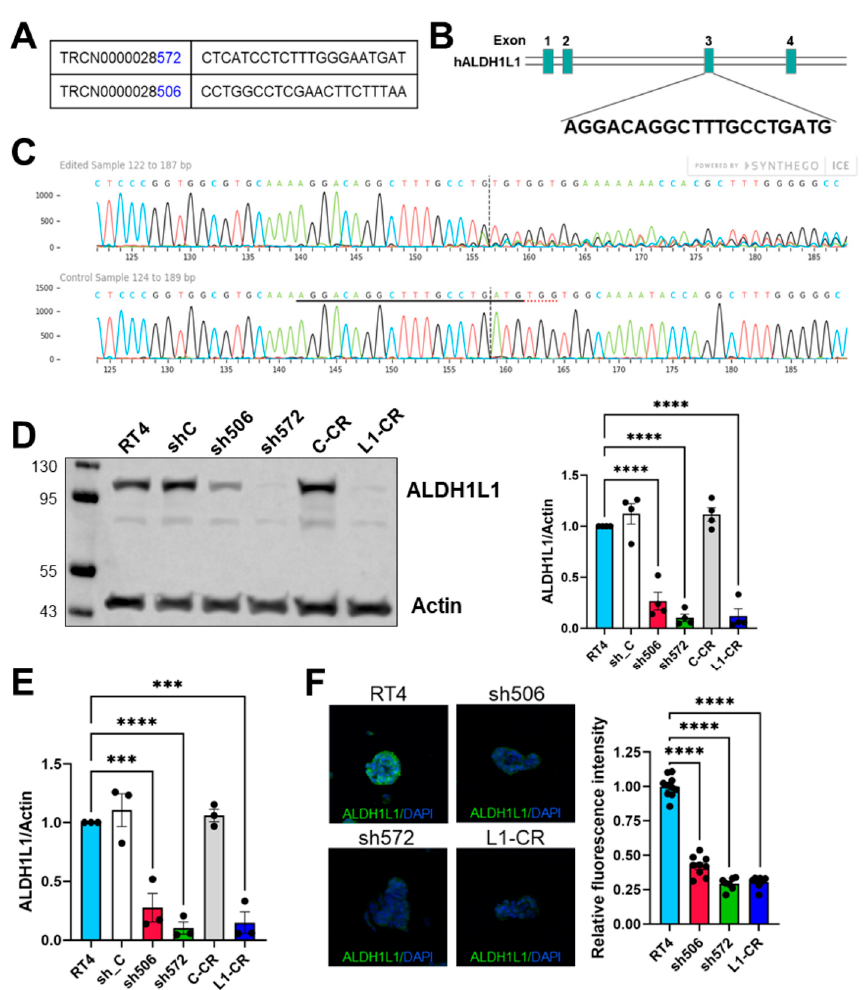
Figure 2. ( A ) shRNA targeting sequences of ALDH1L1 gene, ( B ) ALDH1L1 sequence in exon 3 targeted by CRISPR/Cas9, ( C ) genomic sequencing of the RT4 clone L1-CR and control RT4 cells confirms successful targeting ALDH1L1, ( D ) ALDH1L1 protein levels ( left panel) and bands quantification ( right panel), ( E ) Distribution of ALDH1L1 mRNA levels, ( F ) Immunofluorescence staining of ALDH1L1; plot shows quantification of green fluorescence (ALDH1L1) using Fiji-Image J (NIH). Apparent residual fluorescence in clones 572 and L1-CR represents background. Multigroup comparisons were performed by a one-way ANOVA with Dunnett’s multiple comparisons using GraphPad Prism 9. **** p < 0.0001; *** p < 0.001.